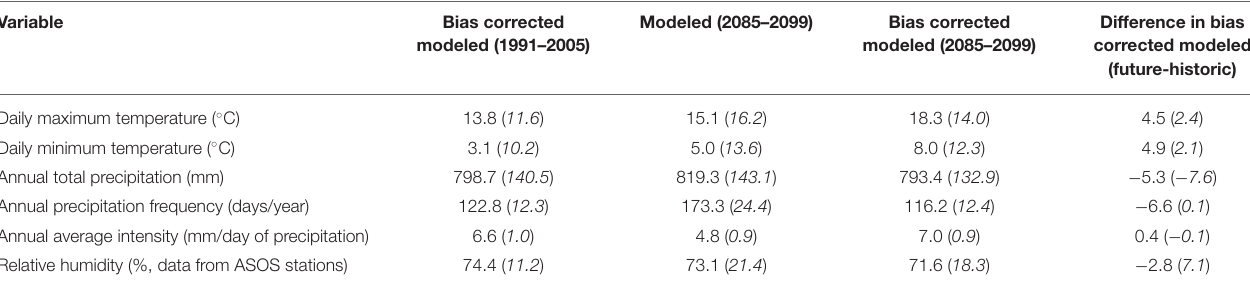
TABLE 2 | Average ( standard deviation ) of bias corrected WRF variables for the historic and future model runs.